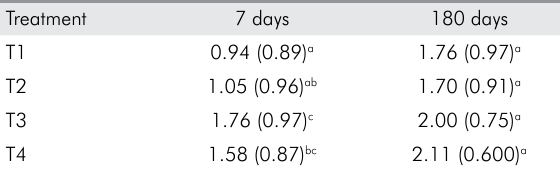
Table 2. Mean CDH scores at observation periods, according to treatment. Mean (S.D.) Treatment